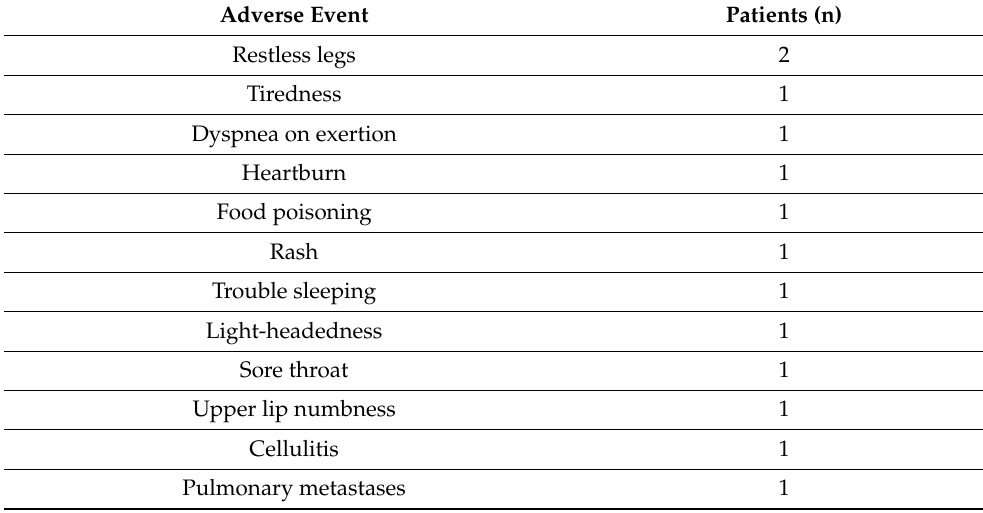
Table 6. Adverse effects.